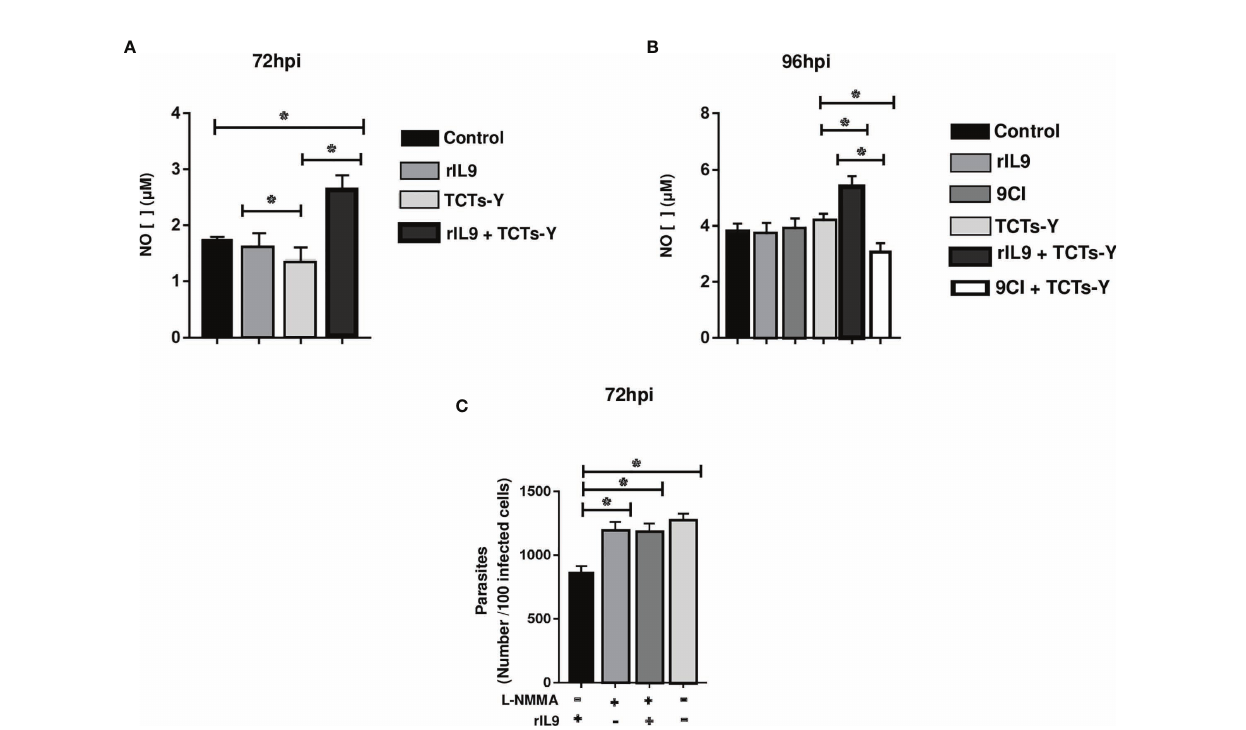
FIGURE 3 | rIL9 treatment (post-treatment) increased NO production after 72 h of parasite multiplication in C2C12 cells and addition of L-NMMA inhibited the parasitic control of these cells. C2C12 cells were infected with tissue derived trypomastigotes of Y strain (TCTs-Y) for 3 h and then treated with rIL9 or 9CI. After 72 hpi (A) and 96 hpi (B) , the supernatant was collected and assayed for NO concentration using the Griess test. After 72 hpi of L-NMMA, rIL9, or L-NMMA + rIL9 treatment, infected and untreated cells were fi xed with 4% PFA for 15 min and then DAPI stained to count the number of internalized parasites (in 100 infected cells) (C) . Anova test *p < 0.001.